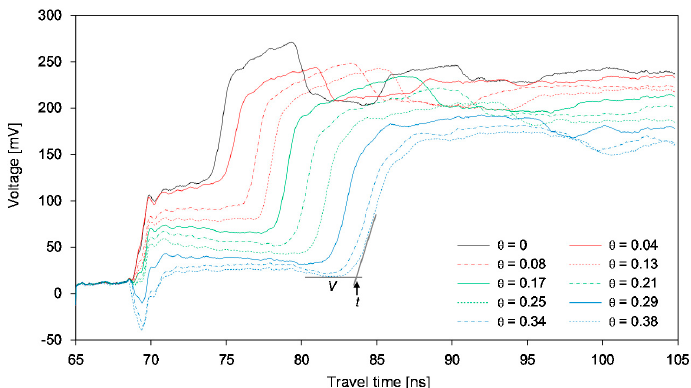
Figure 3. Variance of the signals in the uniform soil with water content obtained by using a probe with a length of 50 cm. θ denotes the SWC.